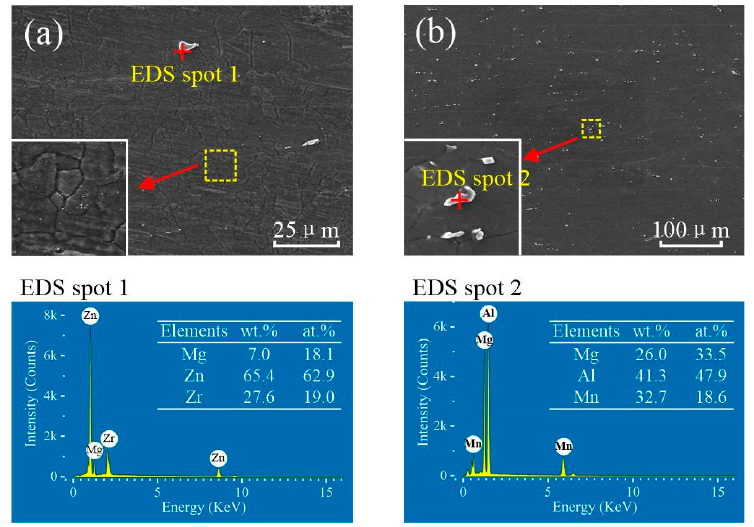
Materials 2022 , 15 , x FOR PEER REVIEW Figure 9. Precipitate particles distribution and EDS scanning results of BMs: ( a ) ZK60; ( b ) ATZ511.